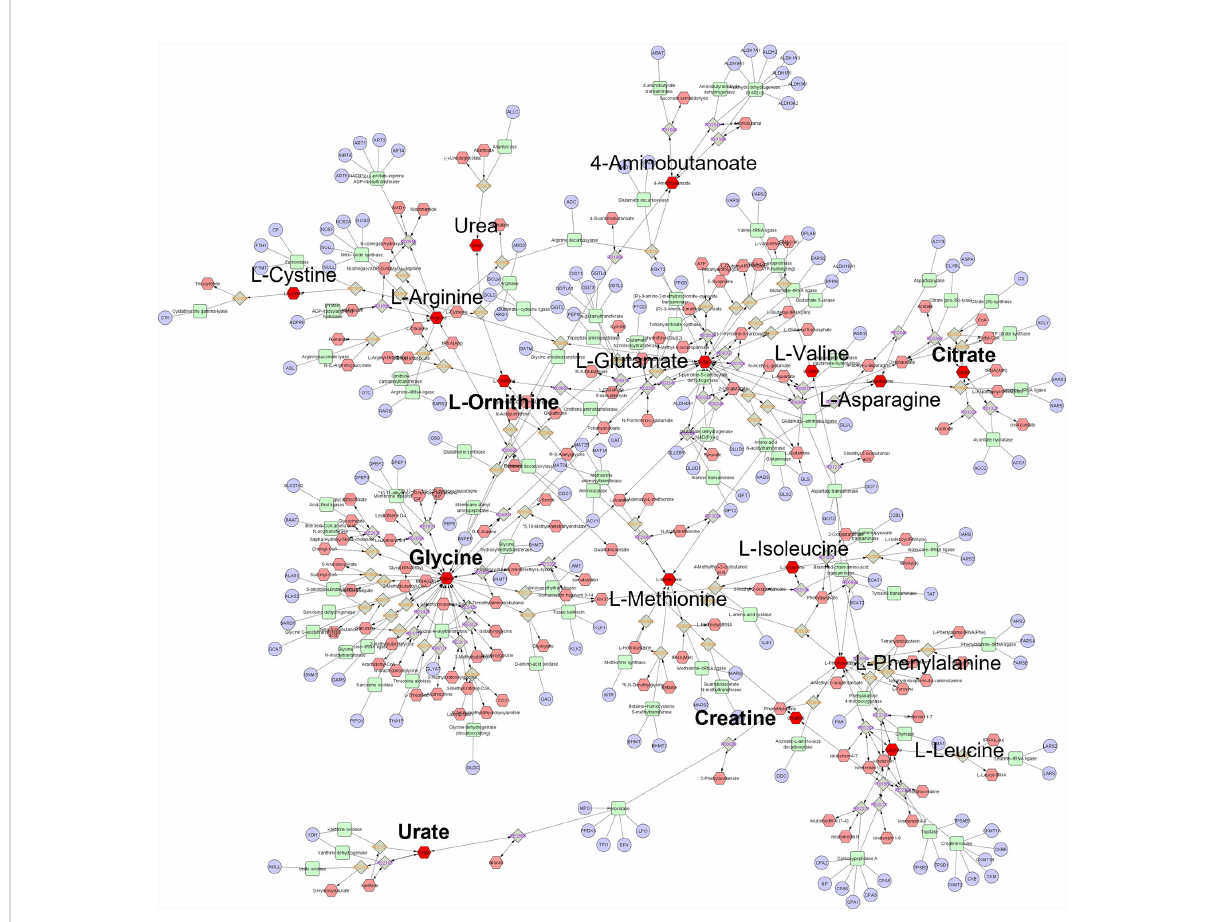
FIGURE 3 Global metabolic network pathways identi fi ed with top ranking Ethnicity model metabolites. Nodes correspond to an identi fi ed KEGG compound/gene/reaction, and edges indicate a signi fi cant correlation between nodes. Annotated red hexagons represent input metabolites, pink hexagons represent network metabolites, blue circles represent encoding genes, green quadrangles represent associated enzymes and grey diamonds represent metabolic reactions. Metabolites in bold are hub metabolites by degree and betweenness centrality measures.